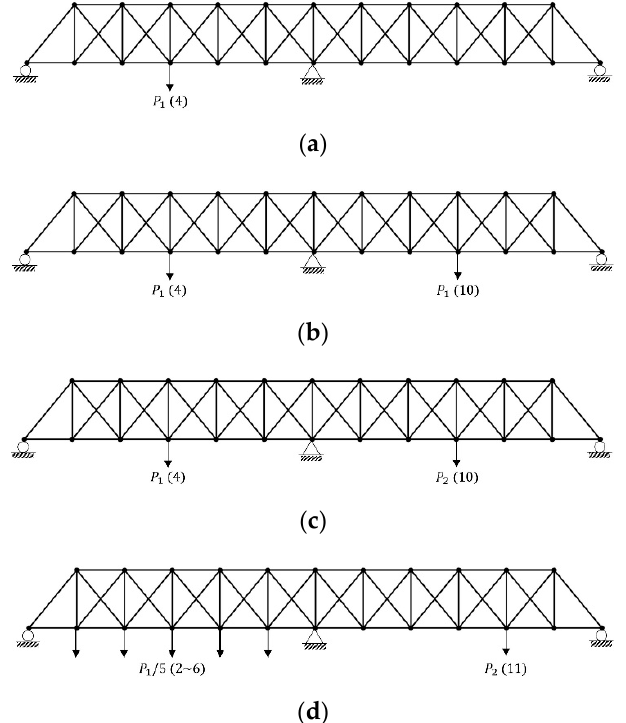
Figure 6. Load conditions for real deformed shape assumed by FEM model (truss): ( a ) RDS1, ( b ) RDS2, ( c ) RDS3, ( d ) RDS4.